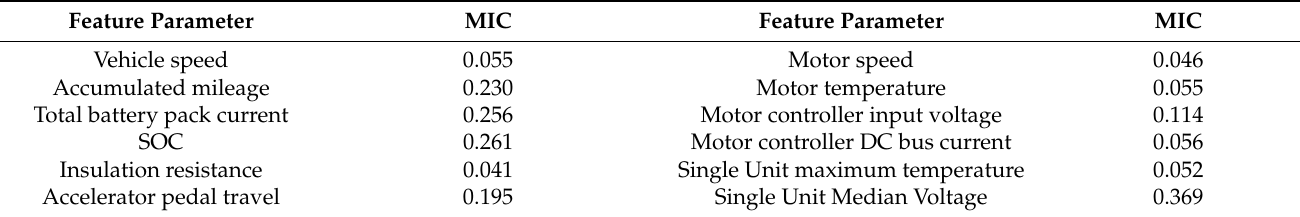
Table 3. The results of MIC of parameter.